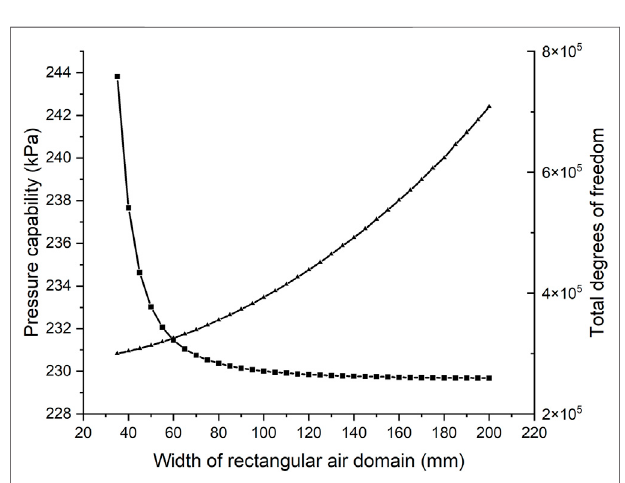
FIGURE 9 | Pressure capability (block) and total degrees of freedom (triangle) with different widths of the rectangular air domain.